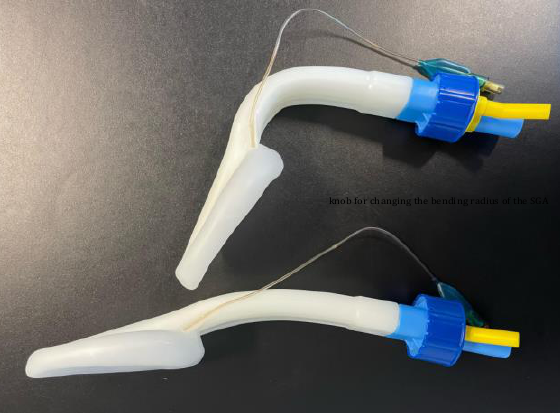
Figure 1. Singularity TM Air Supraglottic Airway Device.